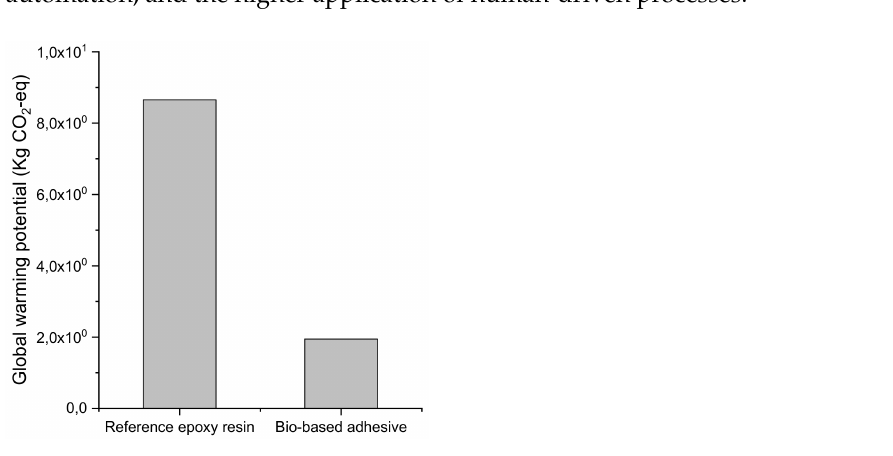
Figure 6. Comparison of GWP between the neat bio-based adhesive and the reference epoxy in terms of CO 2 emissions.